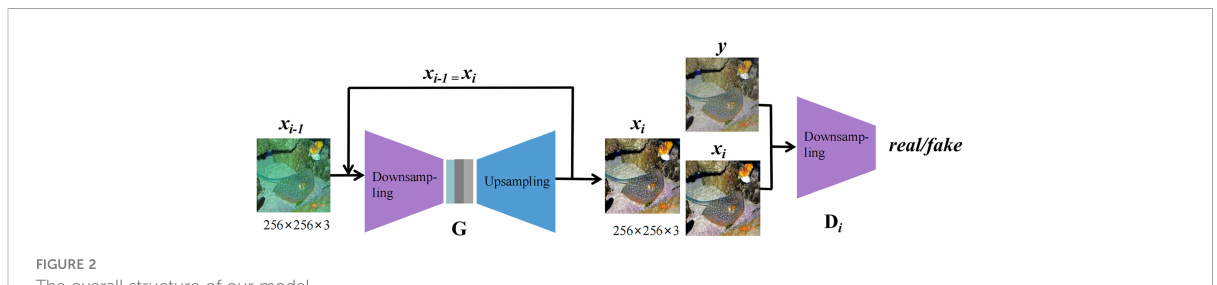
FIGURE 2 The overall structure of our